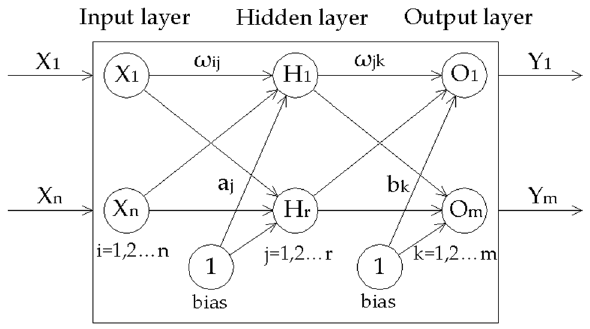
Figure 8. Typical neural network.